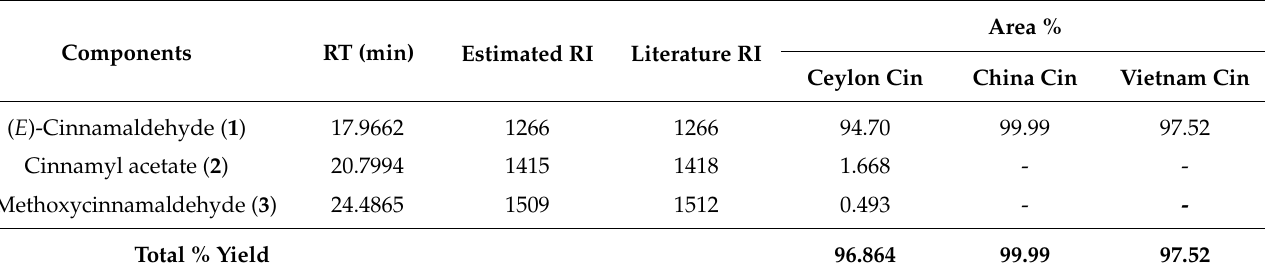
Table 2. Components of the EOs of three cinnamon